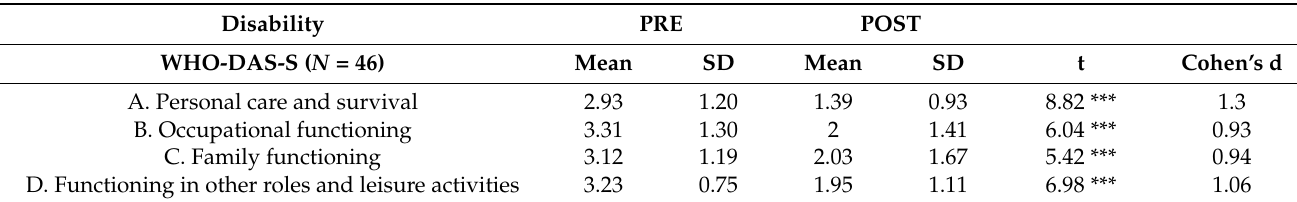
Table 6. WHO-DAS-S. Difference in the pre-/post-intervention means.